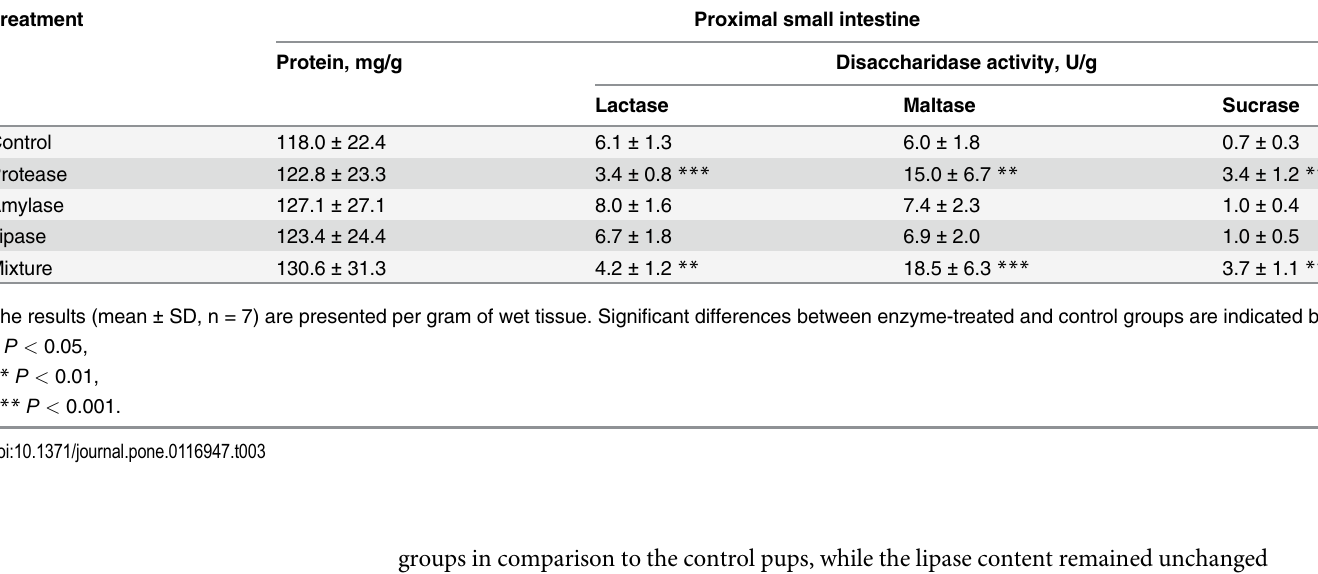
groups in comparison to the control pups, while the lipase content remained unchanged (Table 4).